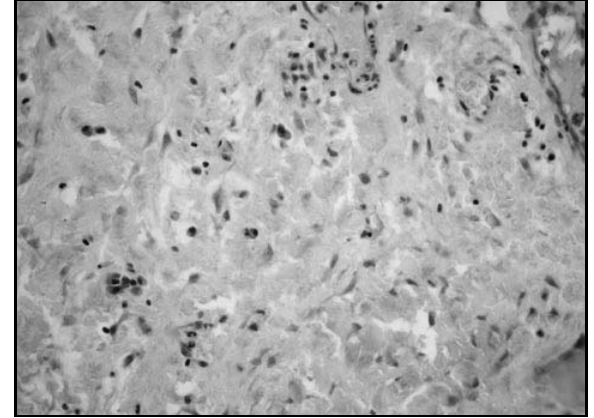
Figura 5 – Positividade difusa para MMP-9 em células mesenquimais em ceratocisto odontogênico (SABC,